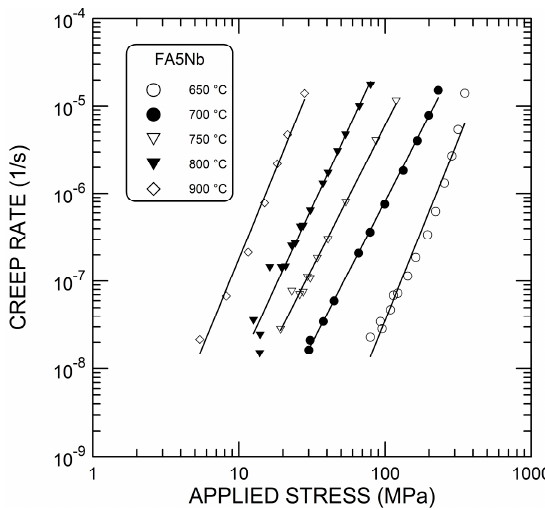
Figure 4. Dependence of the creep rate of the FA5Nb alloy on applied stress.